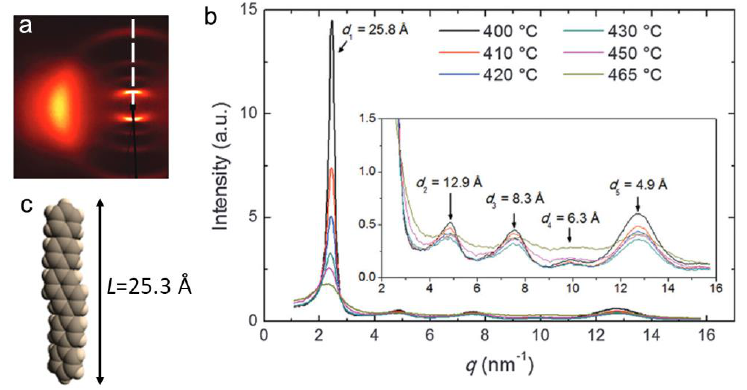
Figure 15. ( a ) Representative wide-angle diffraction pattern of PPNPP showing the measurement direction (white dashed line) for the meridional (‖ n ) intensity profiles shown in the subsequent panel. ( b ) Meridional intensity profiles of PPNPP at selected temperatures (the inset shows a close-up of the higher q reflections). Arrows associate each peak to the corresponding d -spacing. ( c ) PPNPP molecular model and estimated molecular length. Adapted from [59] with permission from The Royal Society of Chemistry.